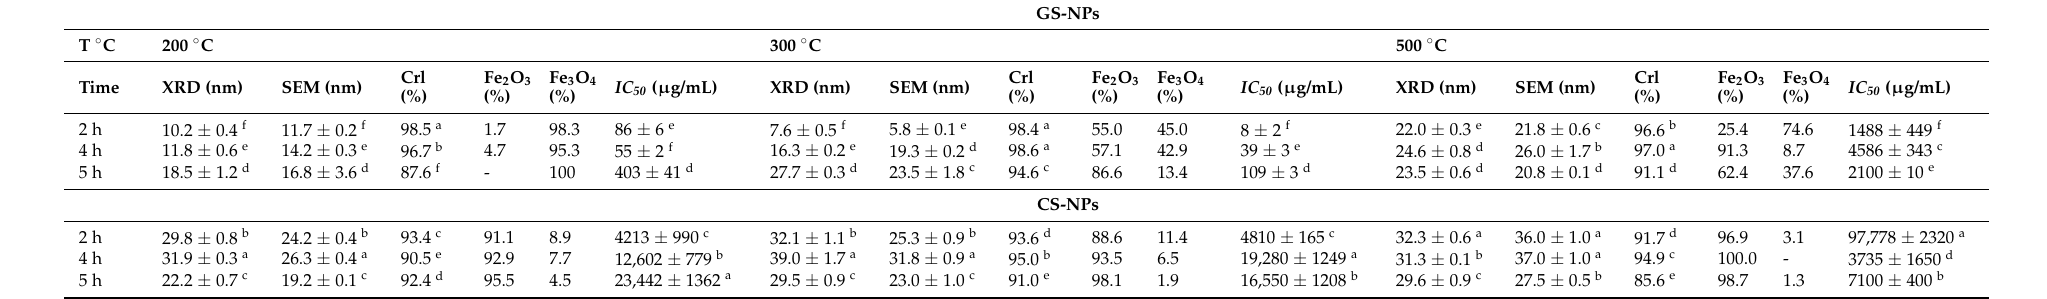
Table 1. Results obtained for different parameters of GS-NPs using PDL extract and CS-NPs using the chemical method at different temperatures (200, 300, and 500 ◦ C) and times (2, 4, and 5 h): average size in nm (from XRD measurements and SEM images), crystallinity percentage (Crl, %), composition (proportion of Fe 2 O 3 and Fe 3 O 4 ), and antioxidant activity (DPPH IC 50 in µ g/mL). GS-NPs